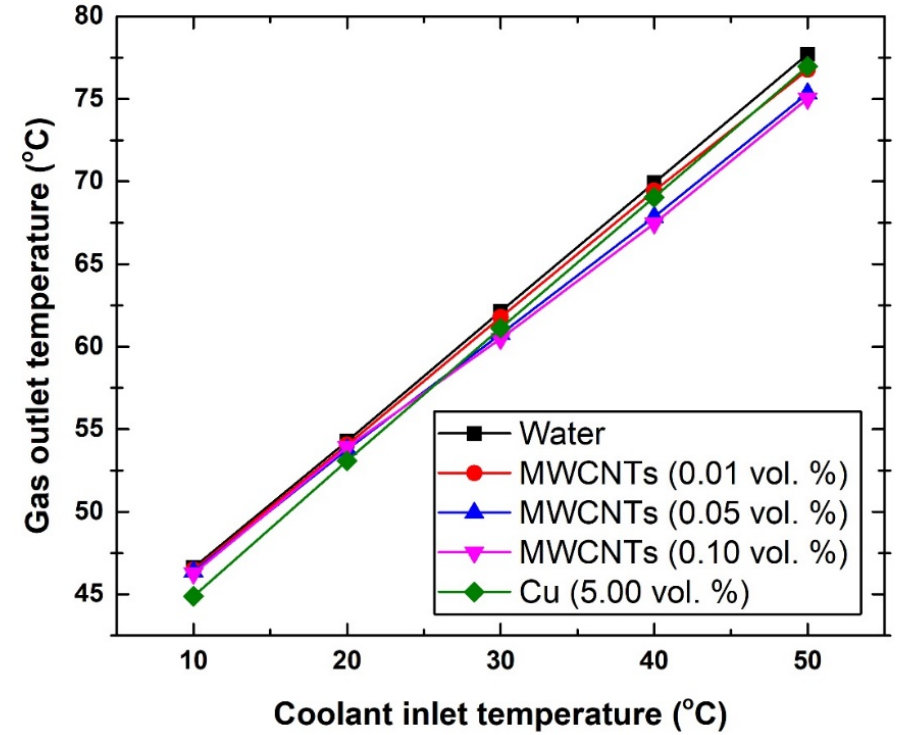
Figure 8 . Changes in gas outlet temperature with respect to coolant inlet temperature.